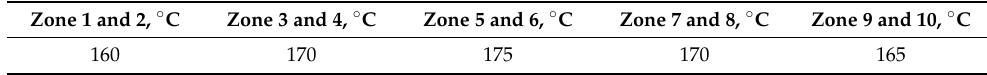
Table 2. Processing parameters of twin ‐ screw extruder.